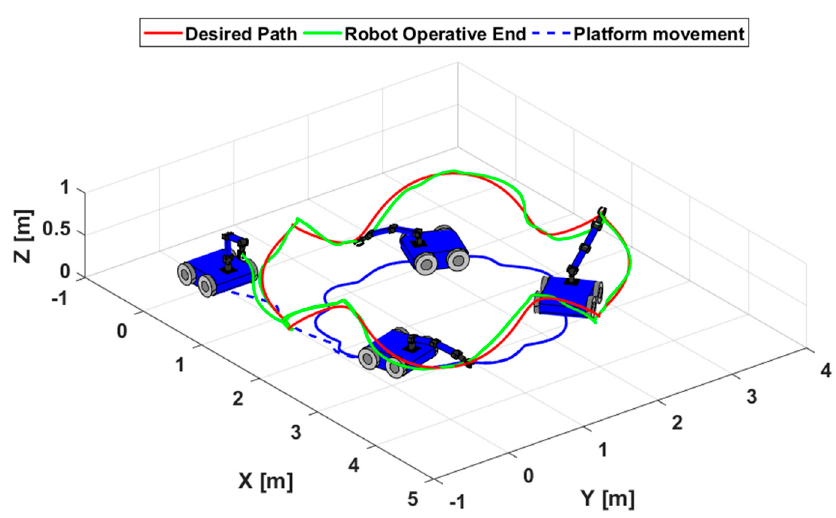
Figure 15. Path considered for the second experiment.